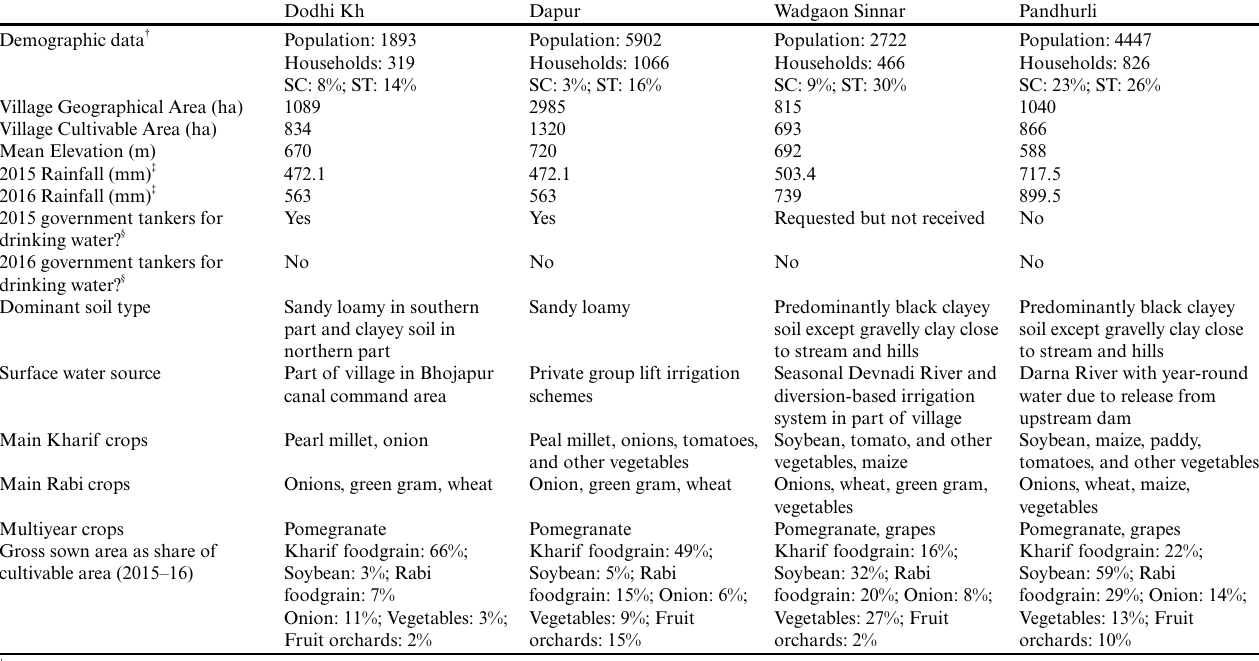
Table 1 . Attributes of selected